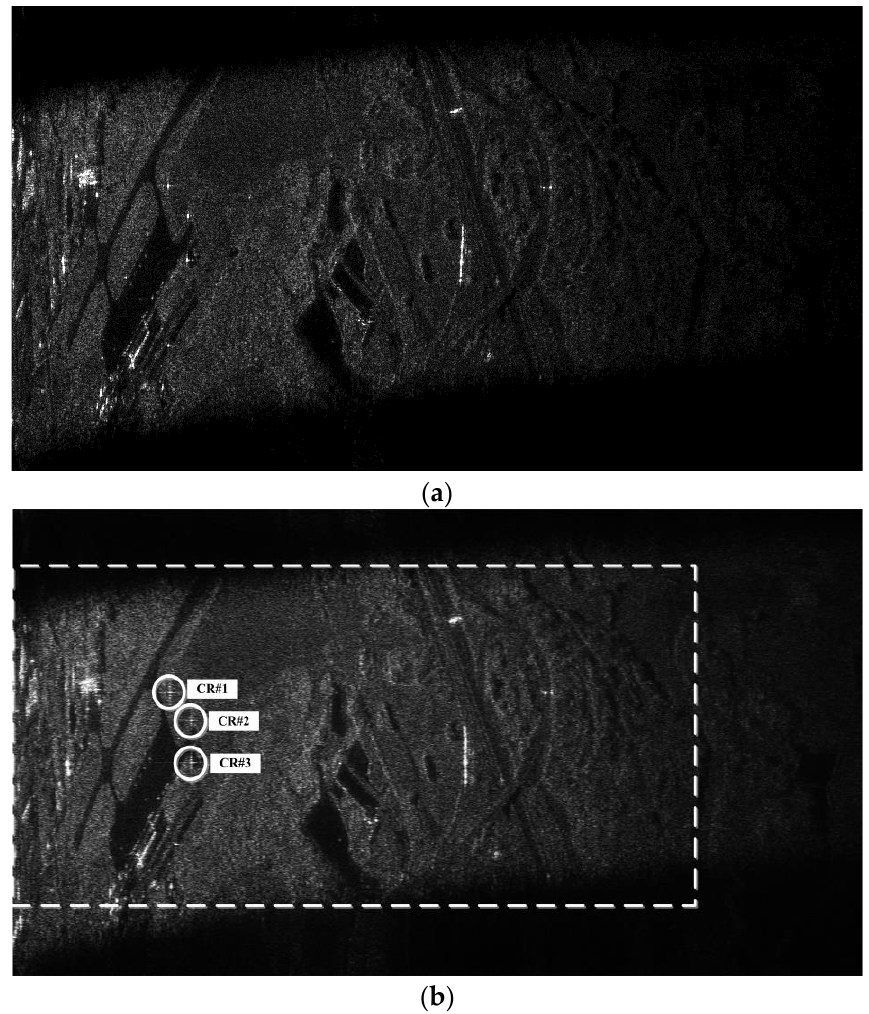
Figure 9. One-burst imaging results of single-channel TOPS SAR. ( a ) Imaging result with NB MoCo. ( b ) Imaging result with LOS MoCo.